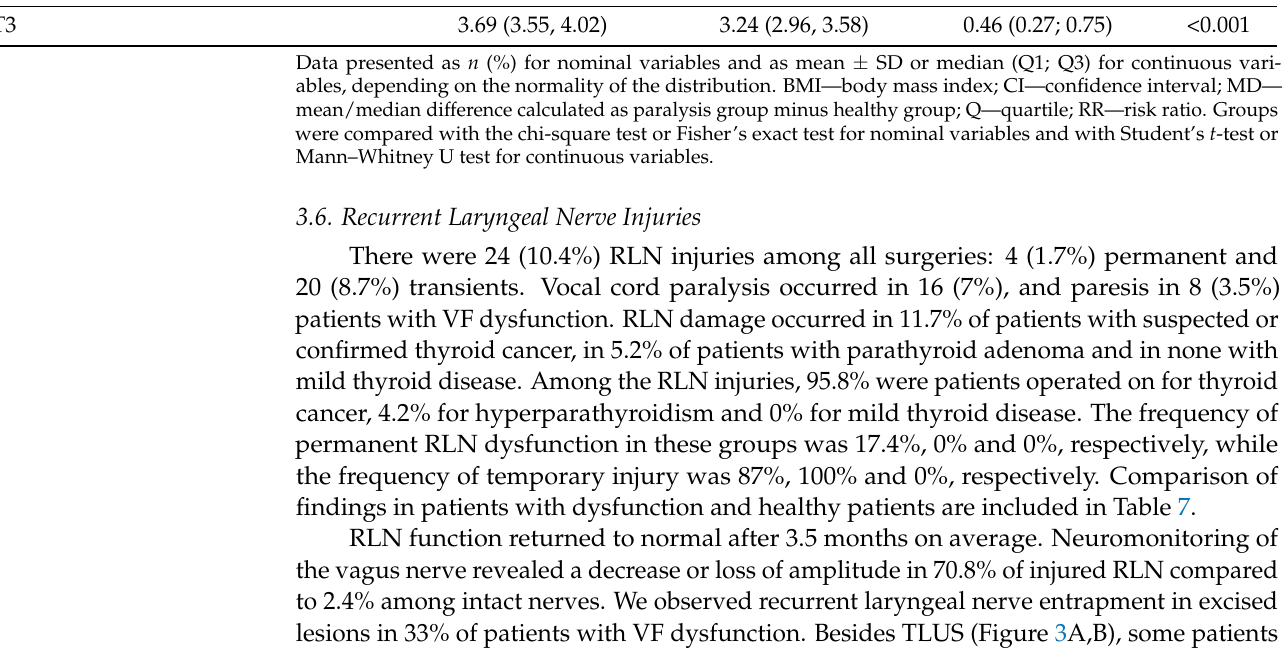
Table 7. Comparison of dysfunction and healthy cases 1–3 days after surgery.